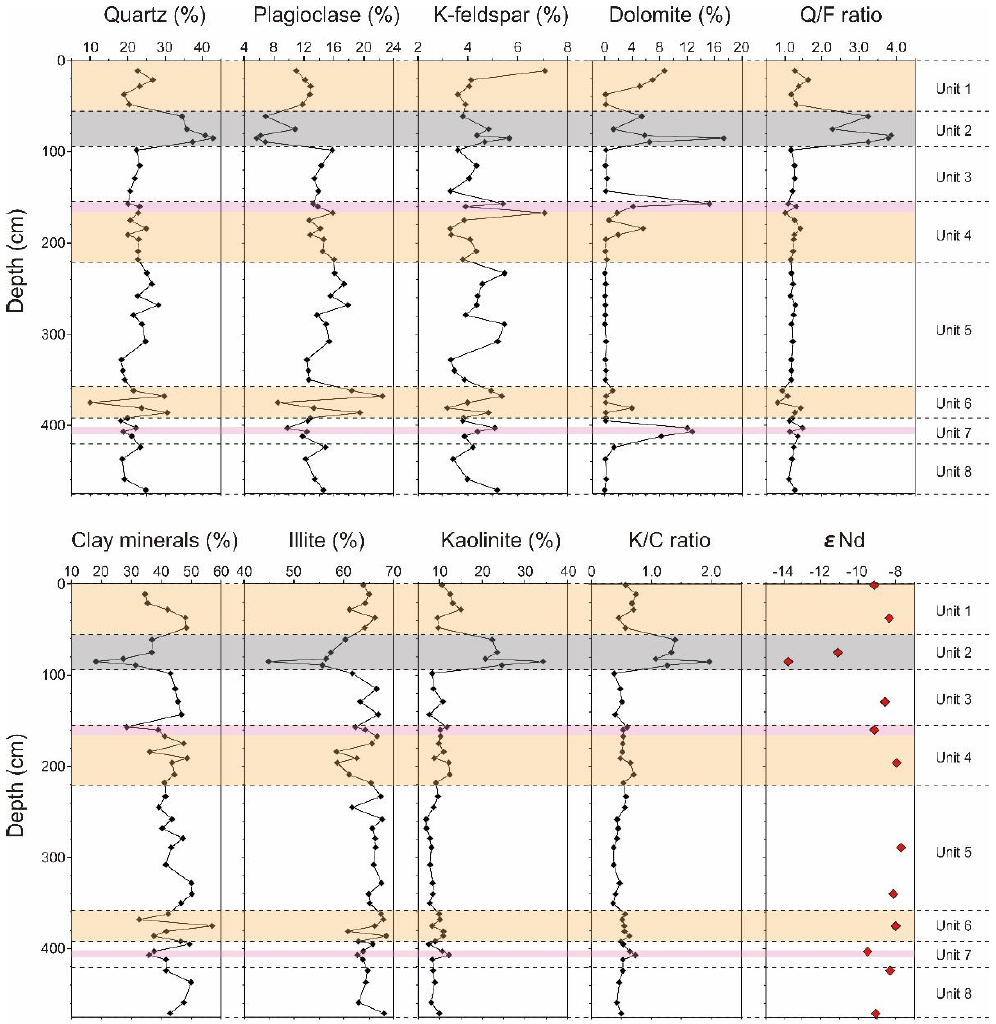
Figure 3. Down-core variation in mineralogical and Nd isotope data in core ARA09C-St03. The dotted lines represent the boundaries of separated units. Q/F: quartz/feldspar. K/C: kaolinite/chlorite.